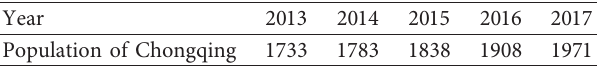
Figure 5: The APE of the three models for validation of Sichuan data. Table 10: Urban population in Chongqing, China, 2013–2017 (unit: ten